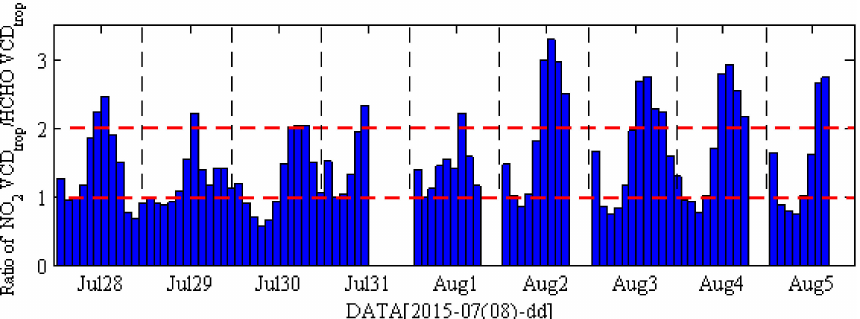
Figure 13. The ratio of tropospheric HCHO and NO 2 vertical column densities in Shanghai from 28 July to 5 August 2015 (6:00~18:00